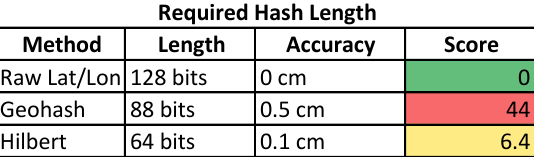
Table 3. Required Hash Length